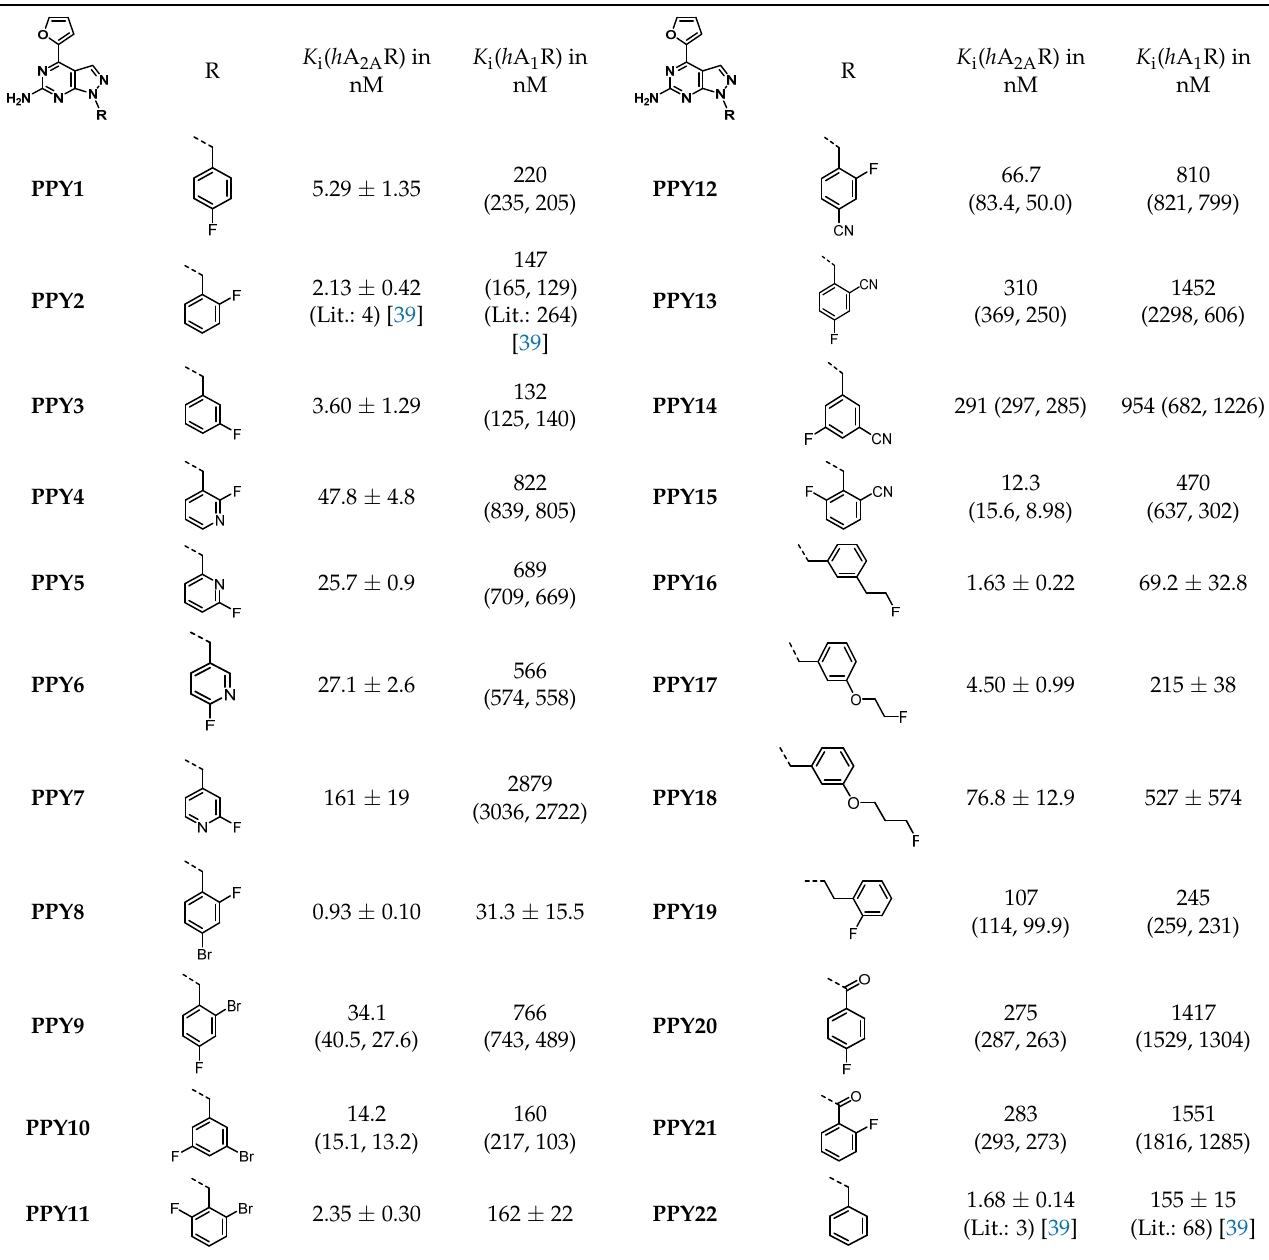
Table 1. Overview of synthesized PPY derivatives and in-house determined in vitro binding affinities towards the A 2A R and A 1 R subtypes; mean value ± standard derivation (n ≥ 3) or mean value (n = 2, single values are shown in brackets).